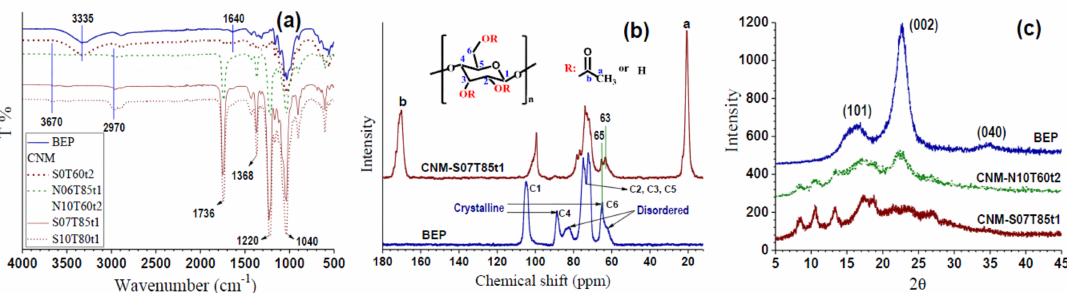
Figure 4. Comparisons of chemical structural properties of BEP with esterified CNP using Fourier transform infrared (FTIR) ( a ), NMR ( b ), and XRD ( c